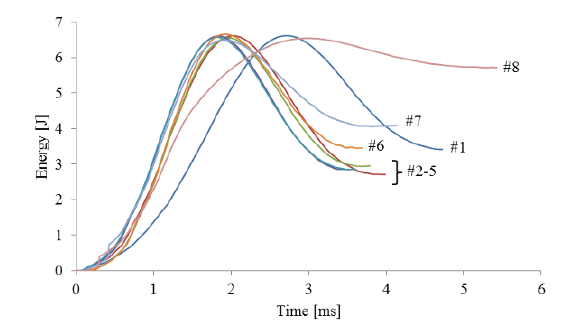
Figure 7. Energy-time records of repeatedly impacted panels.